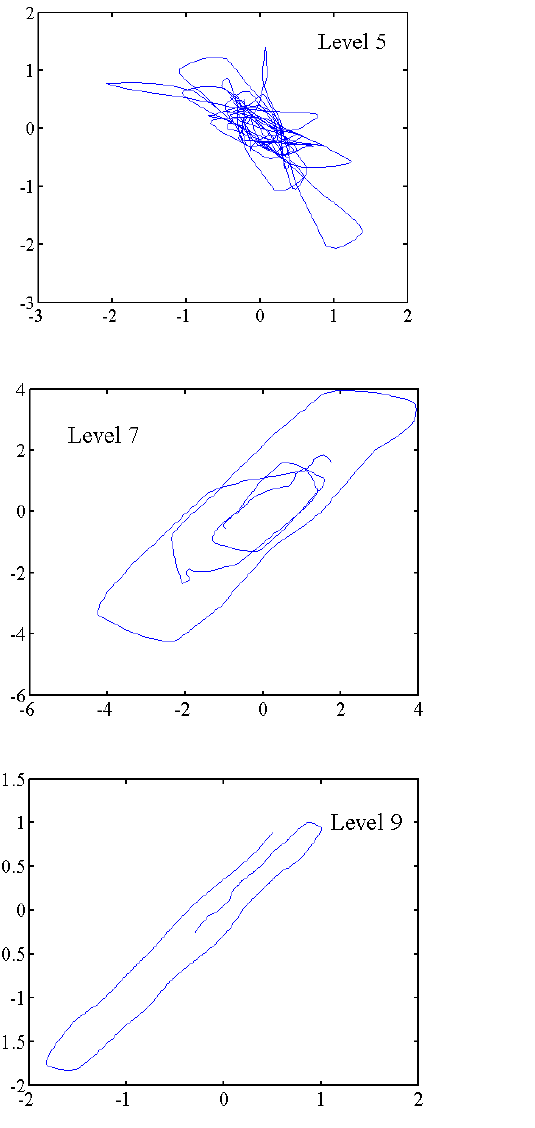
x x − and n d ) for each component (level 1–level 10) using wavelet decomposition of